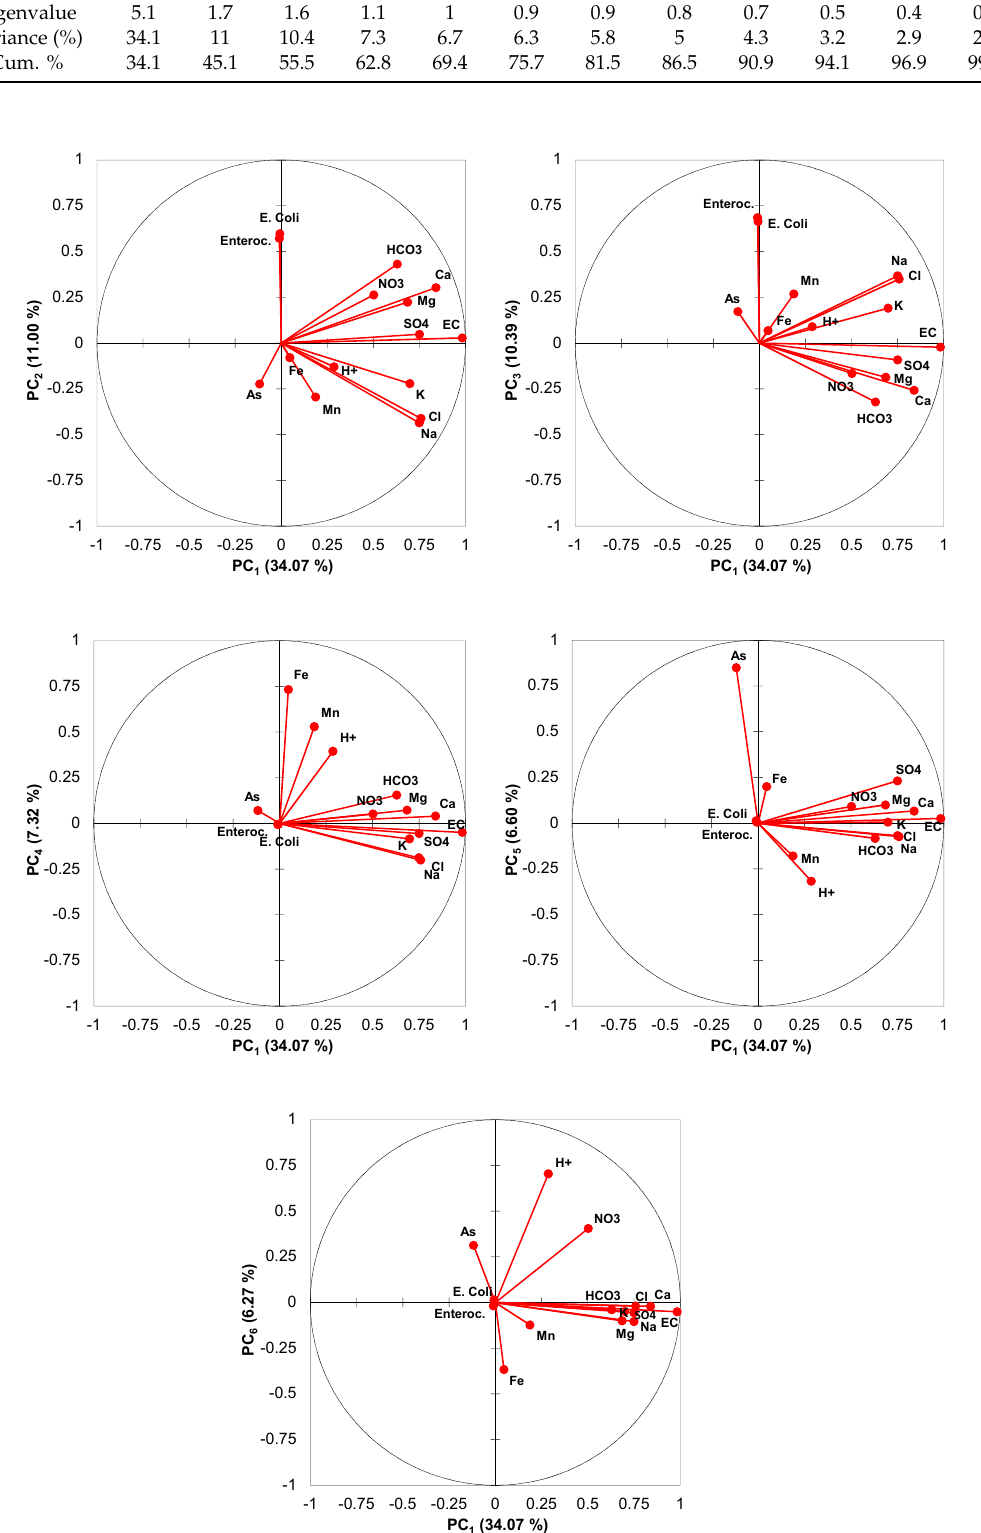
Figure 3. Distribution of the parameters on the six first PCs.